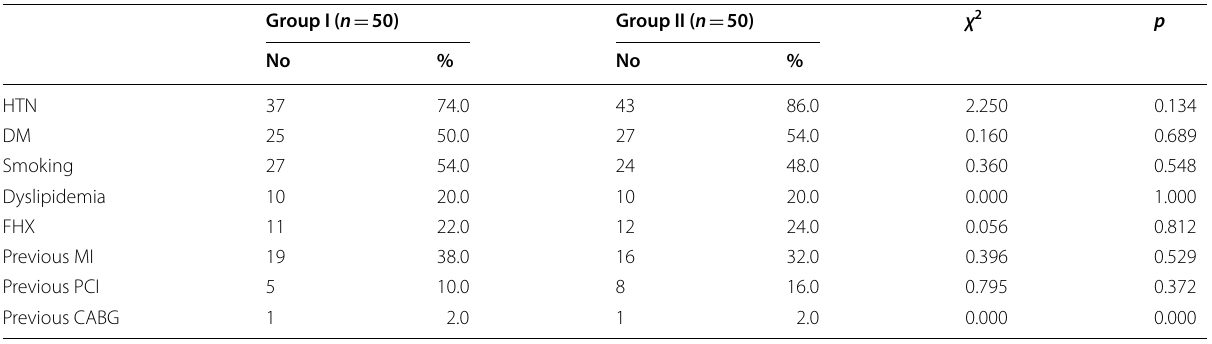
χ 2 Chi square test, p p value for comparing between the studied groups, Group I distal radial artery, Group II conventional radial artery